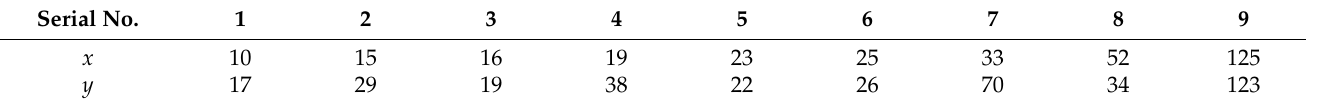
Table 1. The results of K-means++